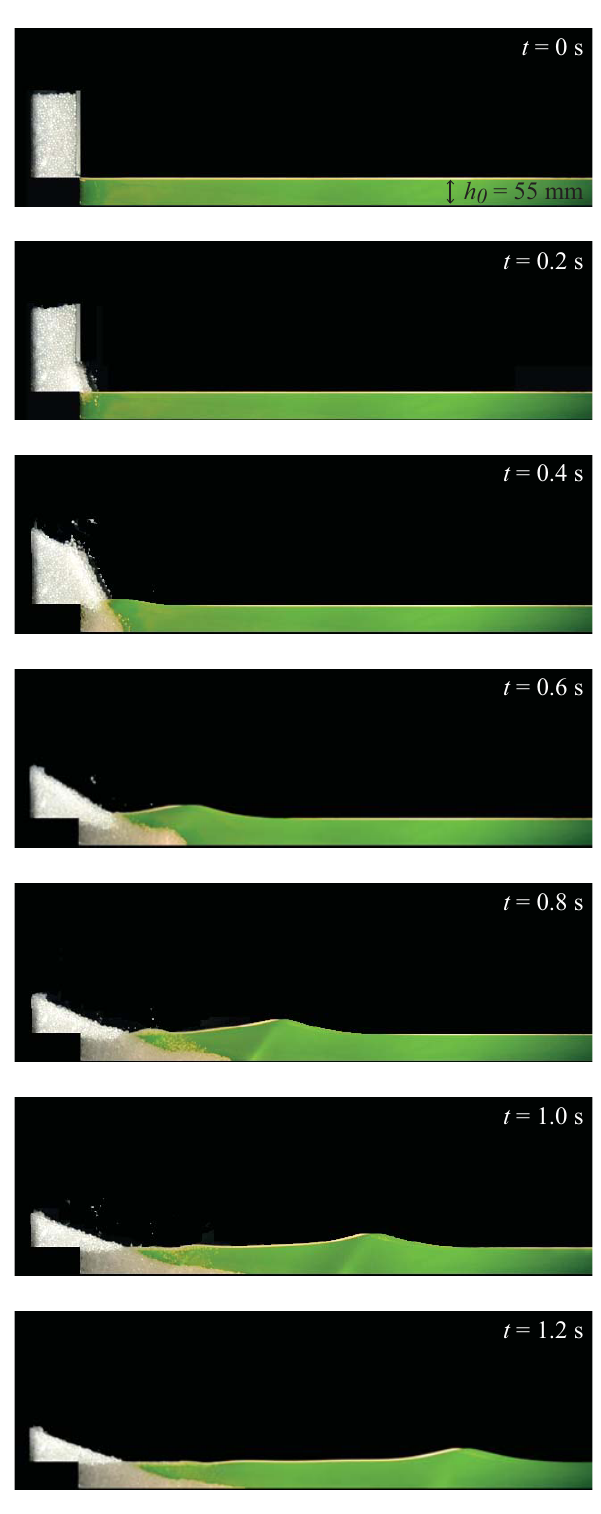
Figure 2. Image sequence showing the propagation of a non- breaking wave due to the collapse of a granular column (mass M = 2 . 8 kg, aspect ratio a = 1 . 8) of 5 mm glass beads into h = 55 mm of 0